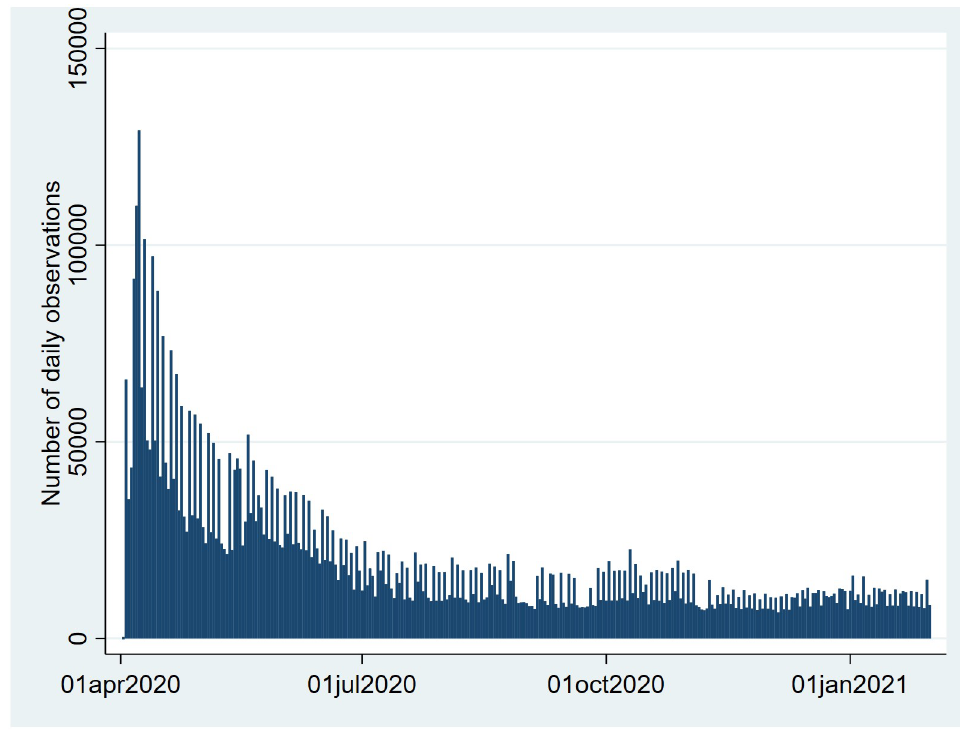
Fig 2. Number of observations per